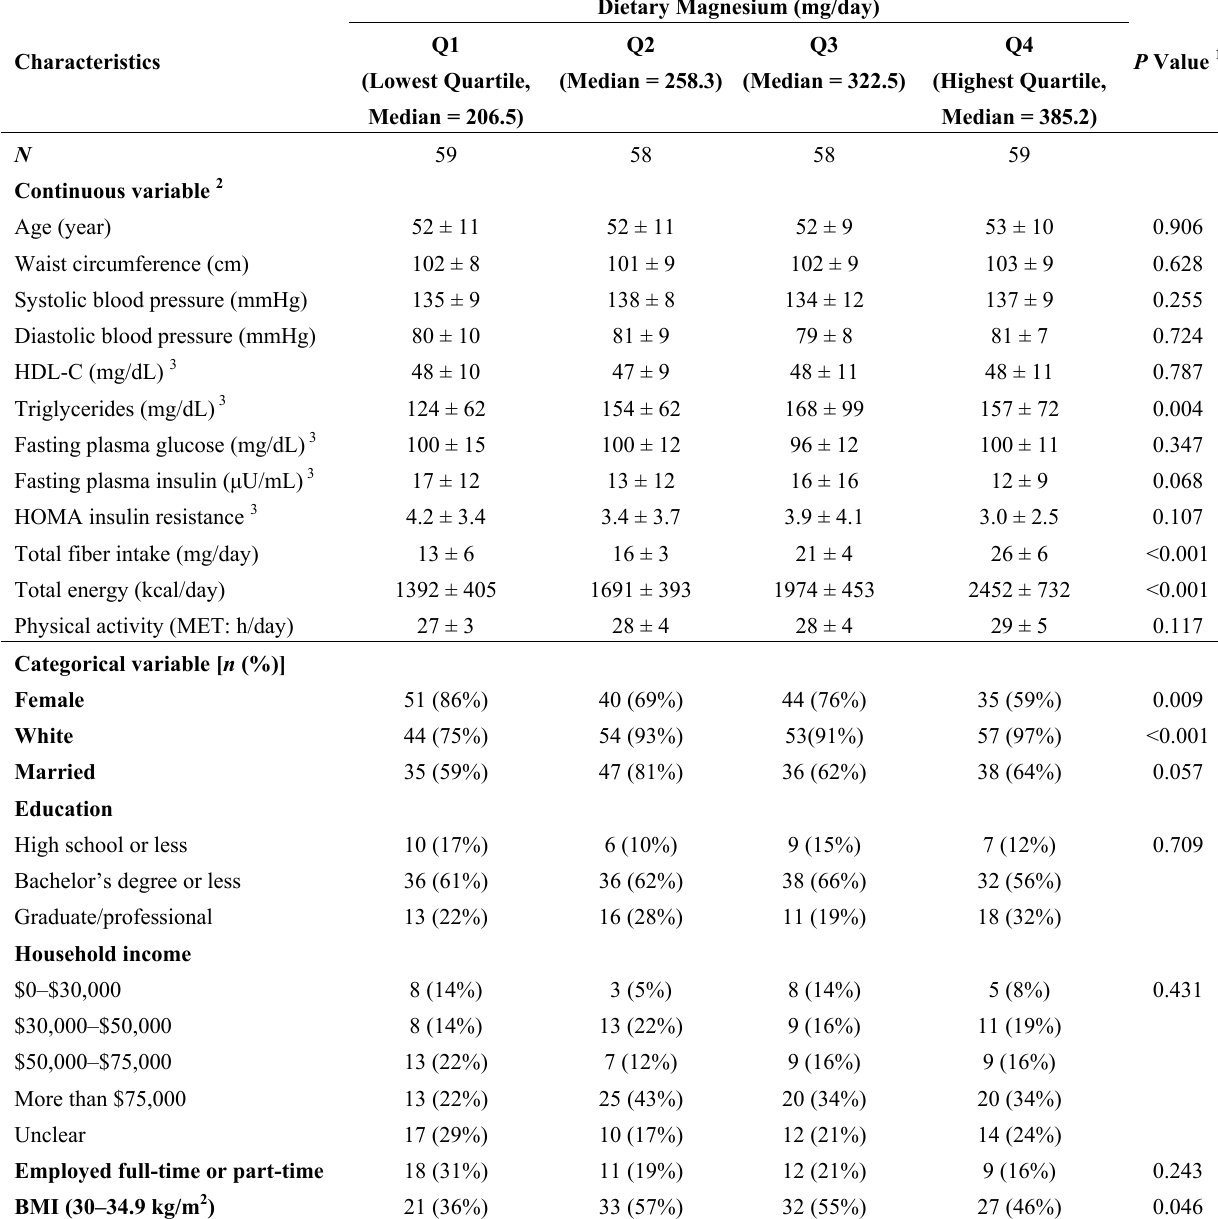
Table 1. Baseline characteristics according to total magnesium intake quartiles among non-diabetic individuals with metabolic syndrome ( n =